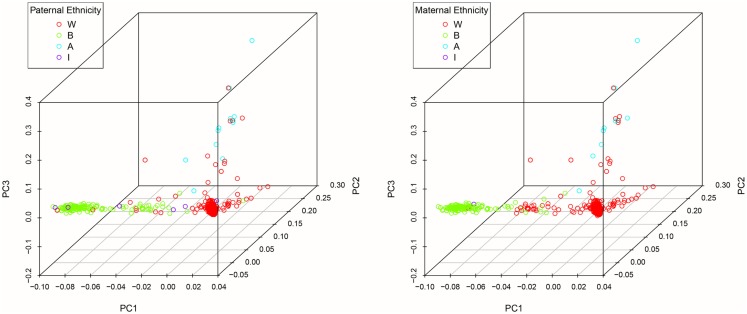
3D scatter plots of the first three PCs color-coded by maternal and paternal reported ethnicity.